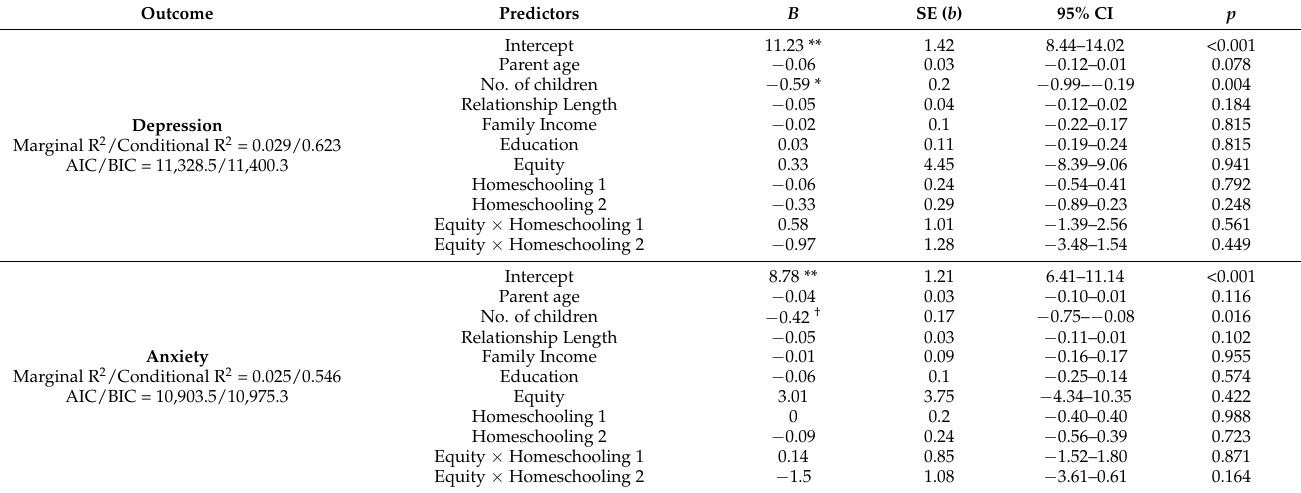
Table 8. Effects of equity and homeschooling status on parents’